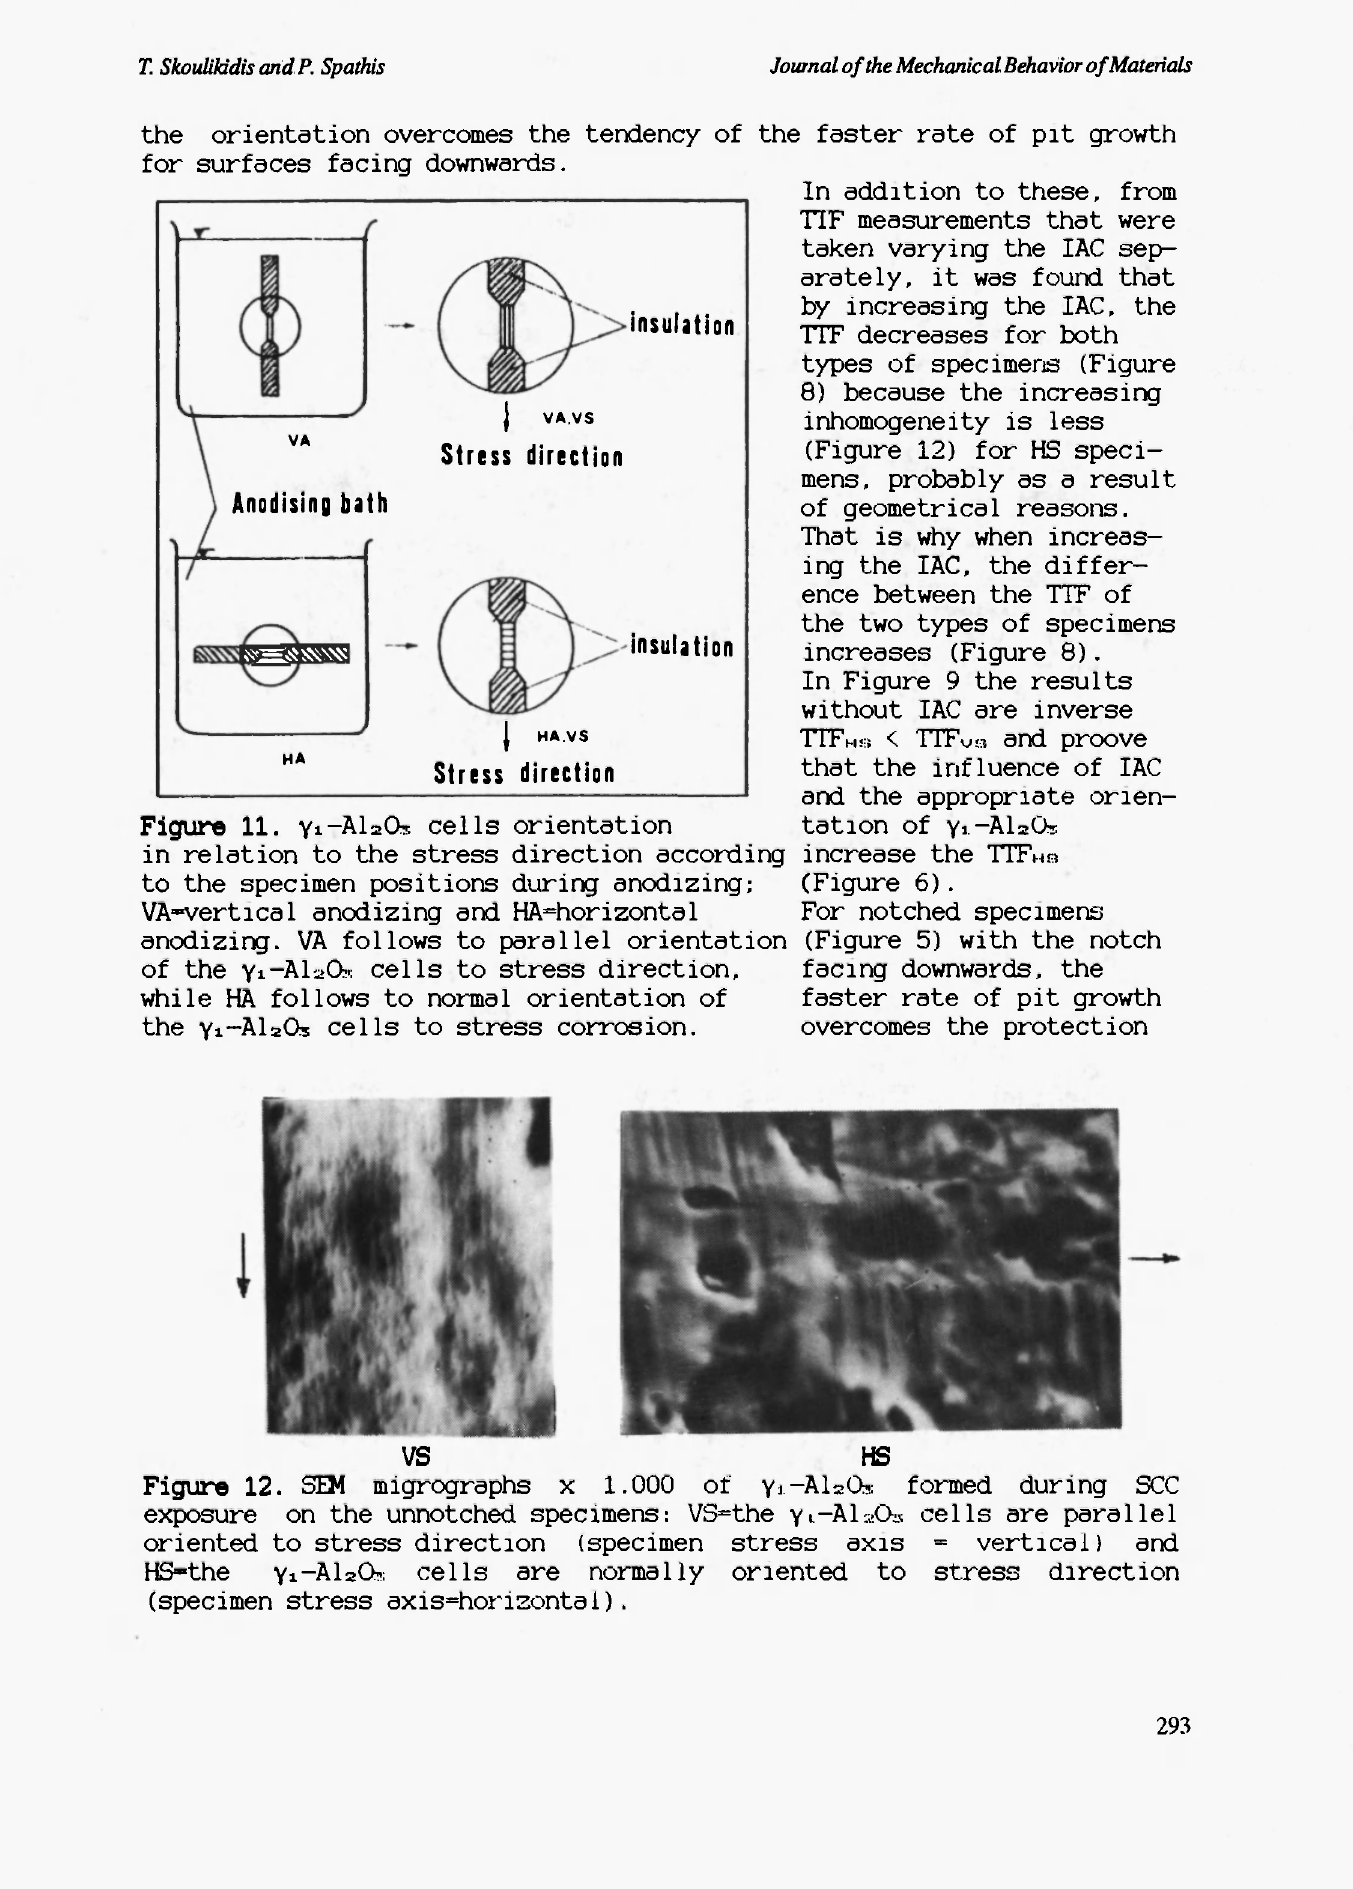
Figure 12. SEM migrographs